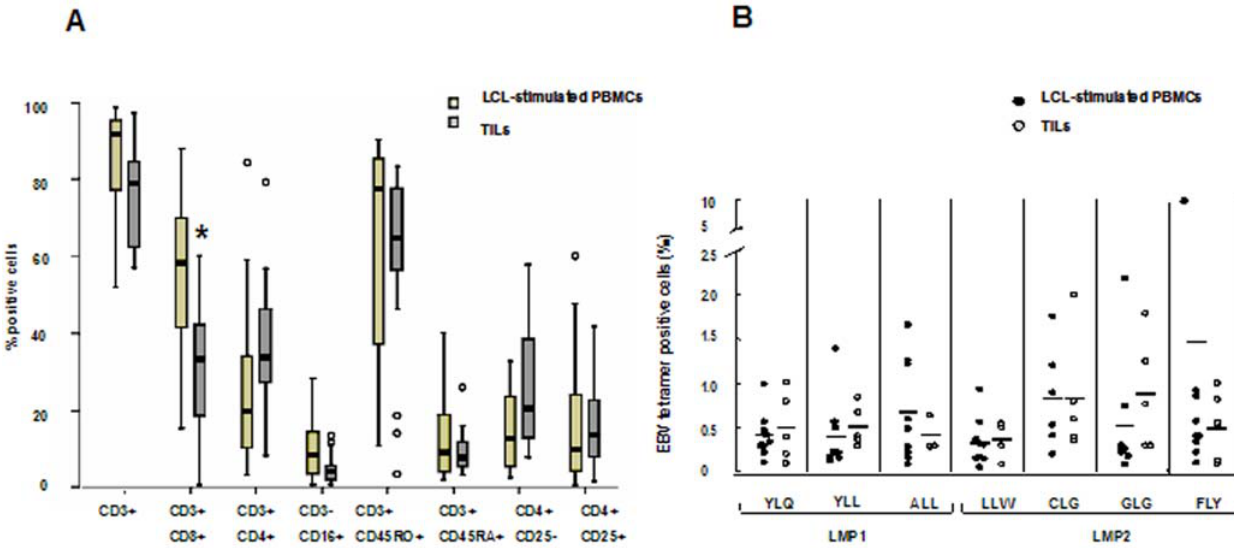
Figure 6. Immunophenotype of LCL stimulated cultures and TILs from NPC patients (A). Surface markers were detected by directly immunofluorescence and FACS analysis in LCL-stimulated cultures (n=13) and tumor infiltrating lymphocyte (n=25) expanded for 1 to 4 weeks in IL- 2 medium without antigen stimulation. A relative decrease of CD8 + cells and increase of CD4 + cells was observed in TILs compared to LCL-stimulated cultures; both cultures showed high percentage of CD3 + CD45RO + and CD4 + CD25 + cells. Frequency of LMP1 and LMP2 epitope-specific T cells in auto-LCL stimulated cultures and TILs from NPC patients (B). LMP1 and LMP2 epitopes specific T cells were detected by EBV tetramer staining and FACS analysis in autologous LCL-stimulated PBMCs (n=9) and TILs (n=6) from NPC patients.